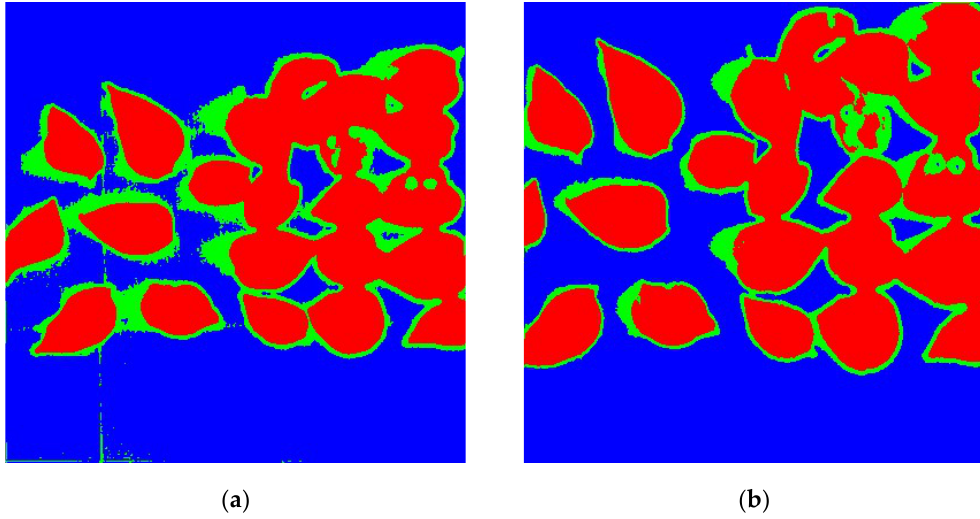
Figure 15. Classification results of original normal images and restored tilting images. ( a ) Results of the original normal image; ( b ) results of calibrated tilting image.